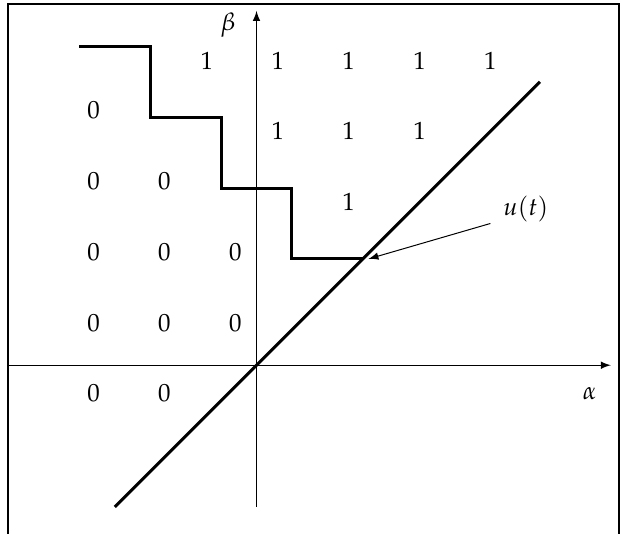
Figure 1. An example of the state space of a system of non-ideal